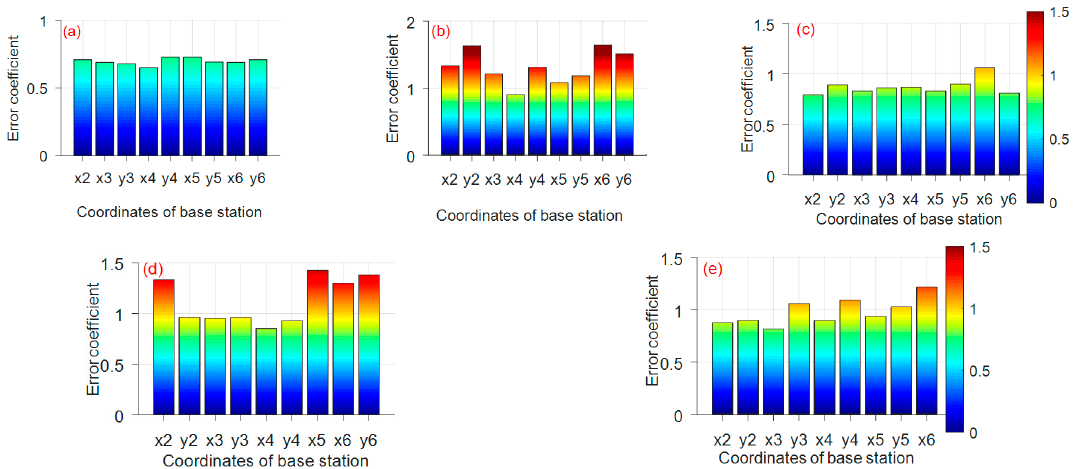
Figure 8. The error coefficient of the hexagonal distribution (( a ) the x -axis is determined by the BS 1 and 2; ( b ) the x -axis is